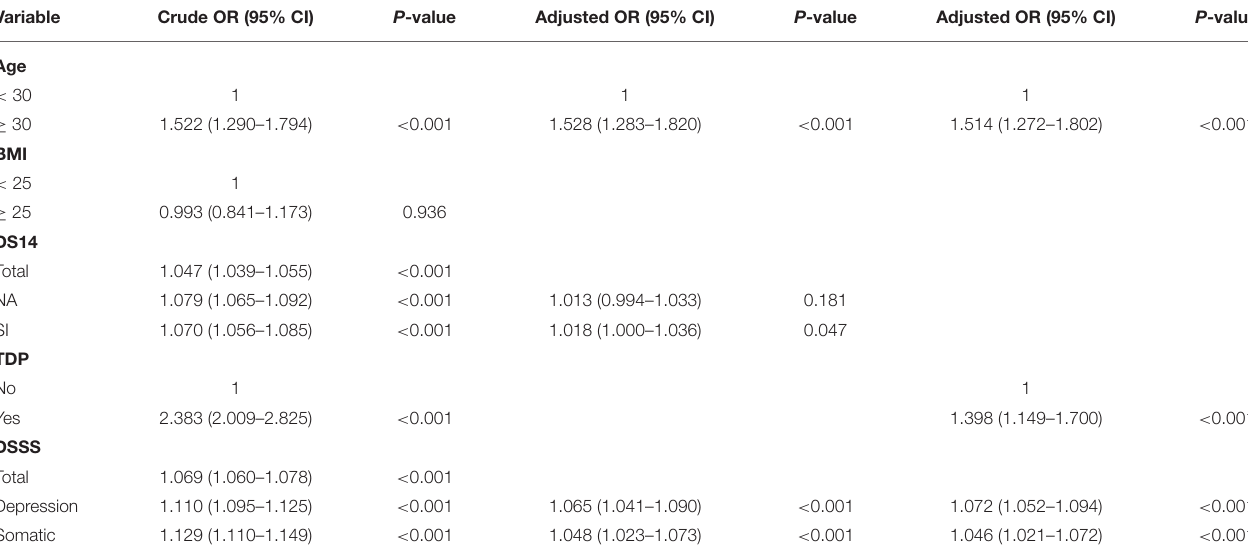
TABLE 2 | Logistic regression analyses of variables associated with moderate/severe LUTS among participants.